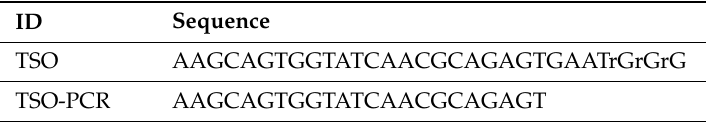
Table 1. Primers used for reverse transcription and library